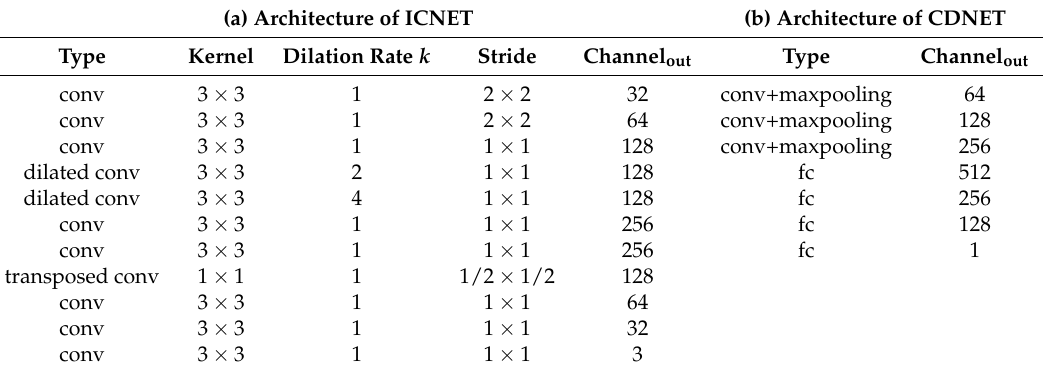
Table 3. Architecture of our networks. “Stride” is the rate of up/down sampling. When “Stride” is 2 × 2, the size of the activation map is reduced by half. “fc” in Type indicates a fully connected layer. In the “conv” type of (b), the “Kernel” is 2 × 2 and the “Stride” is 1 × 1. In the “maxpooling” type of (b), the “Kernel” is 2 × 2 and the “Stride” is 2 ×